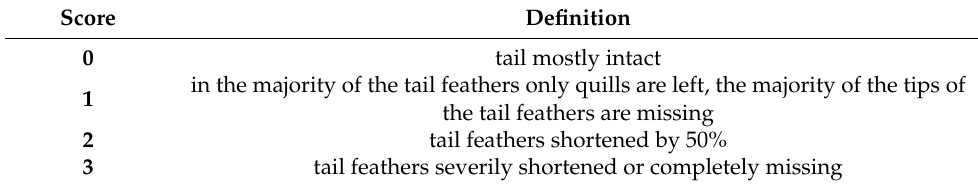
Table A3. Scoring system of the plumage of the tail [25].